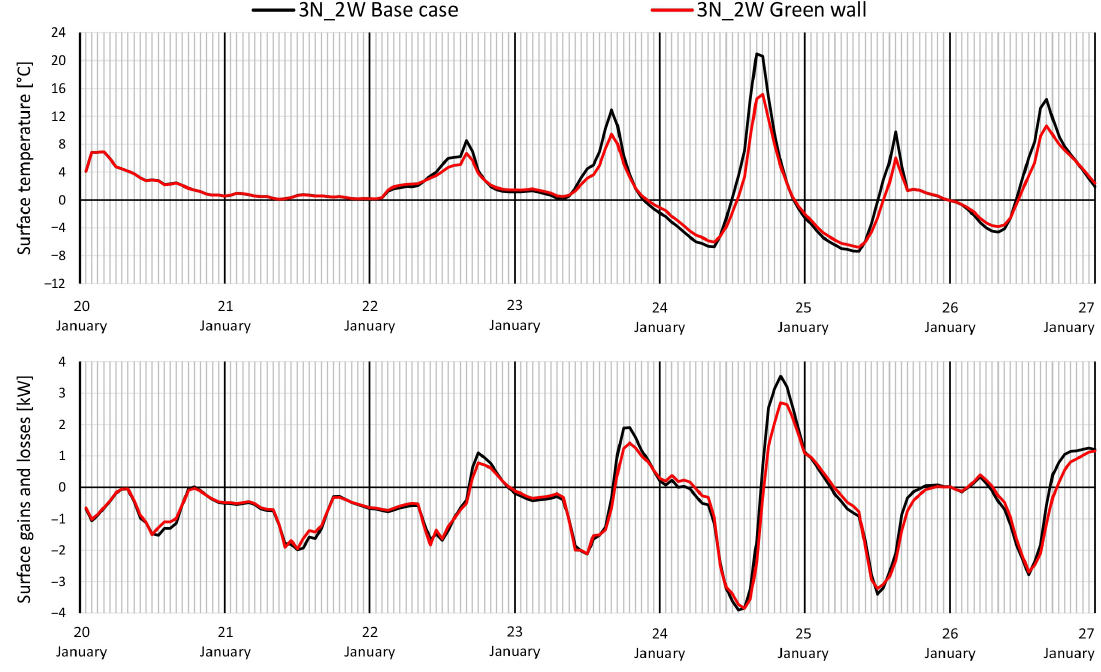
Figure 6. Trend of the external surface temperature ( ◦ C) and surface heat gains/losses (kW) in the winter reference week for the western